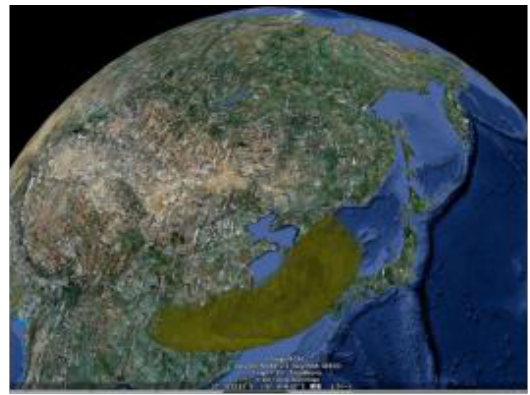
Fig.6 Asian dust cloud at 08:00 on March 20, 2010